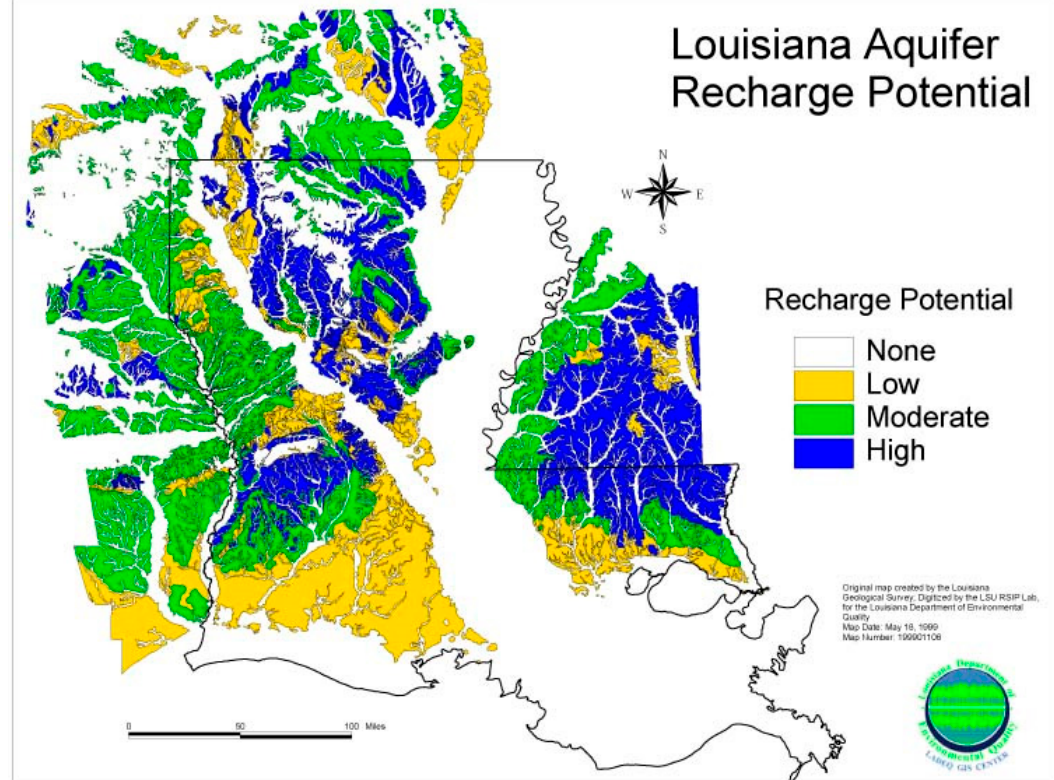
Figure 6. Louisiana aquifer recharge potential. Source: Water: Recharge Potential of Louisiana Aquifers Maps, Louisiana Department of Environmental Quality. 1989. https://deq.louisiana.gov/page/recharge ‐ potential ‐ of ‐ louisiana ‐ aquifers ‐ maps.